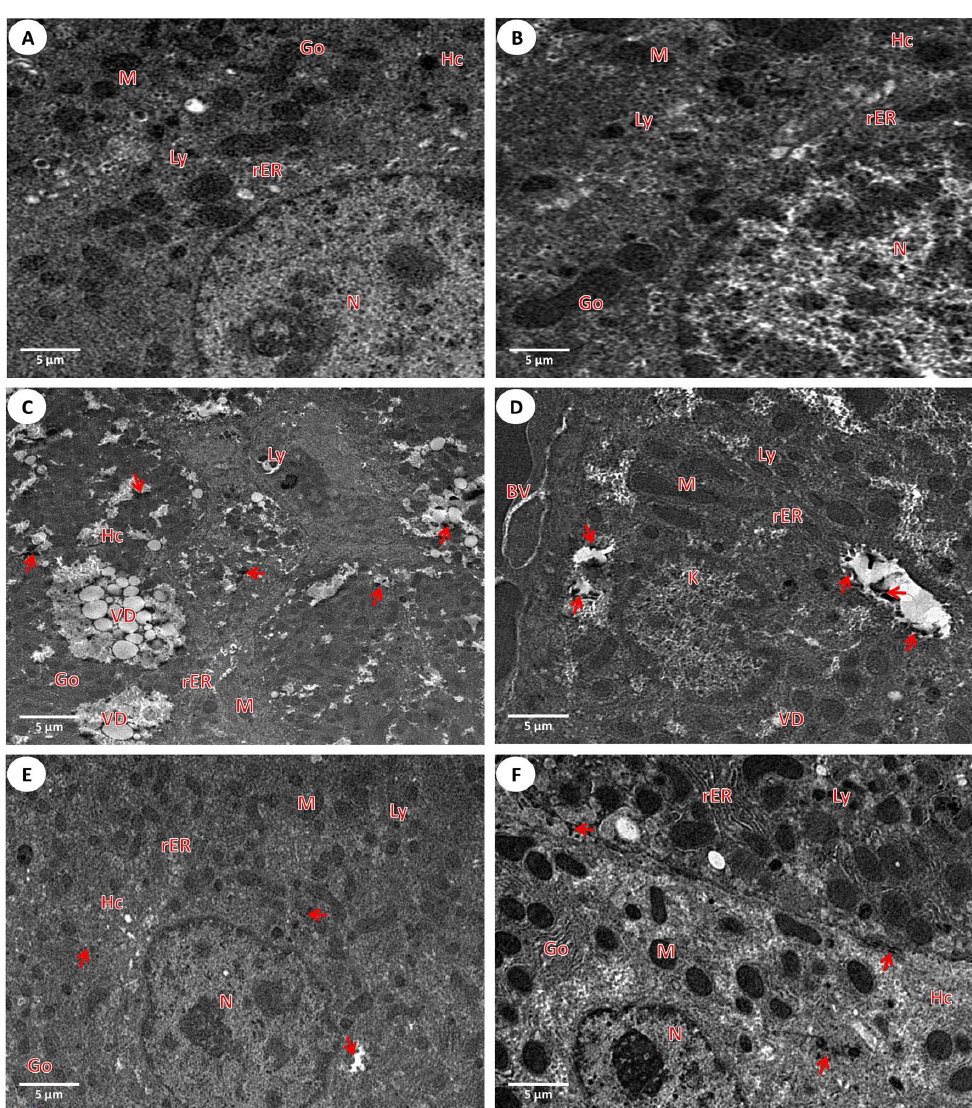
Figure 4. Electron examination of liver slices for experimental groups: ( A ) Hepatic section from the first group (control), ( B ) Hepatic section from the second group (PPE), ( C , D ) Hepatic section from the third group (Fe 2 O 3 -NPs), and ( E , F ) Hepatic section from the fourth group (PPE plus Fe 2 O 3 -NPs). The ultrastructures show the hepatic cells (Hc), the nucleus (N) of hepatocytes, the Kupffer cell (K), the mitochondria (M), the Golgi apparatus (Go), the rough endoplasmic reticulum (rER), the lysosome (Ly), the vacuolar hepatic degeneration (VD), and the iron precipitate (arrows) in the slices (15,000×).